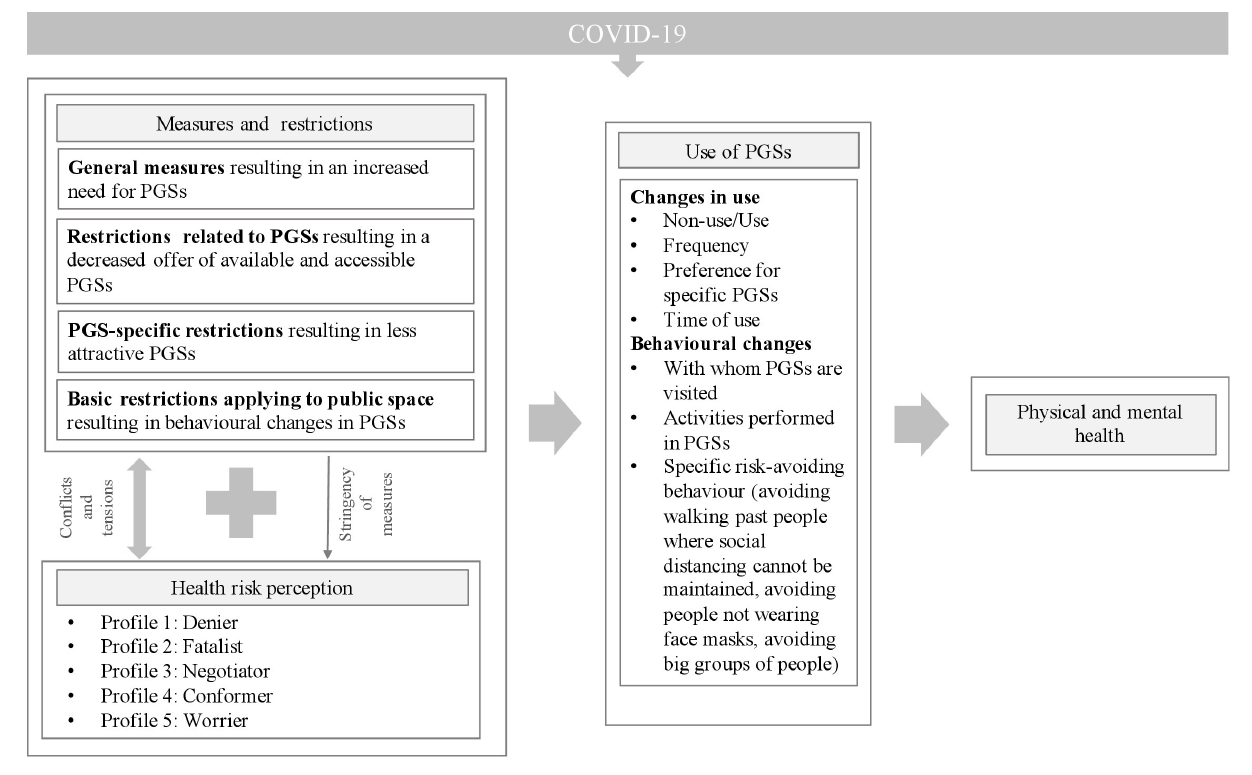
FIGURE 2 | Schematic overview of